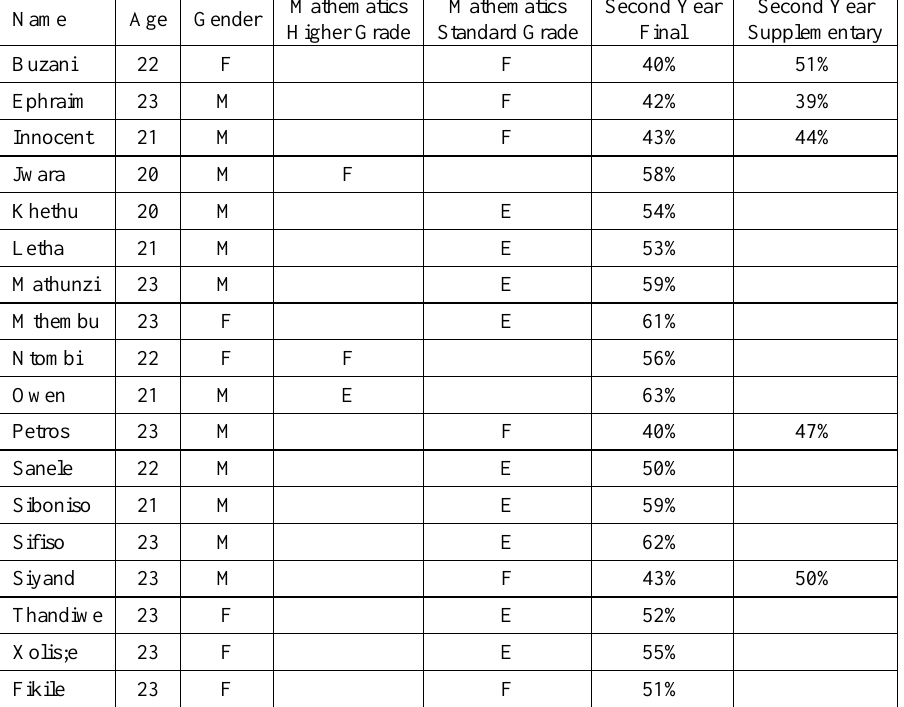
Table 1: Participants in the